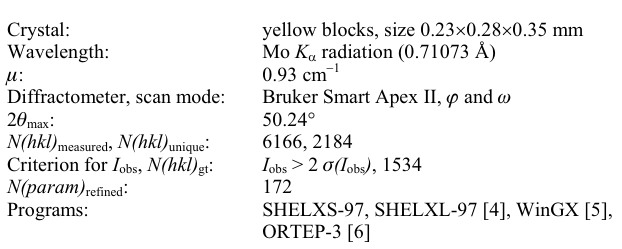
Table 1. Data collection and handling.